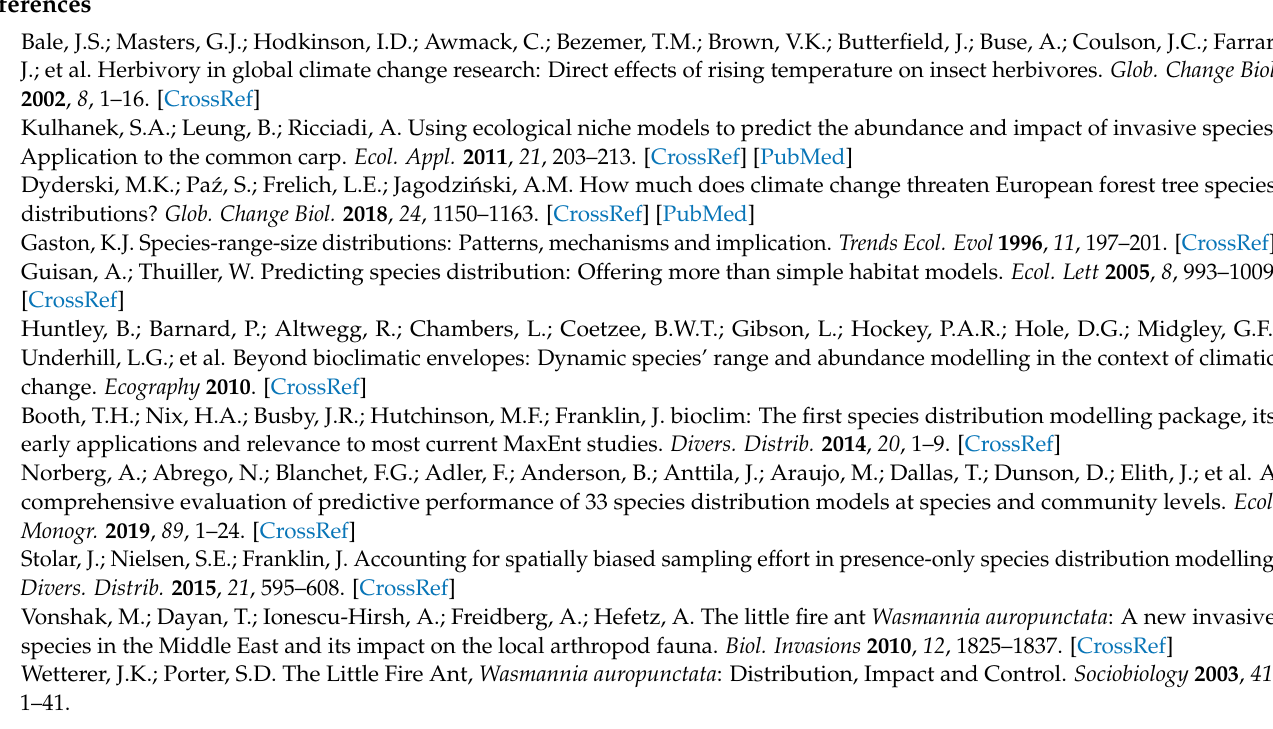
auropunctata . Table S2: Pearson correlation coefficient. Table S3: Prediction of suitable areas under the present and future climate. Figure S1: Environmental envelope model of recorded points of W. auropunctata , the envelope showing the wide range of annual precipitation (Bio 12) against an effective small range of annual mean temperature (Bio 1). Figure S2: Potential distribution map of